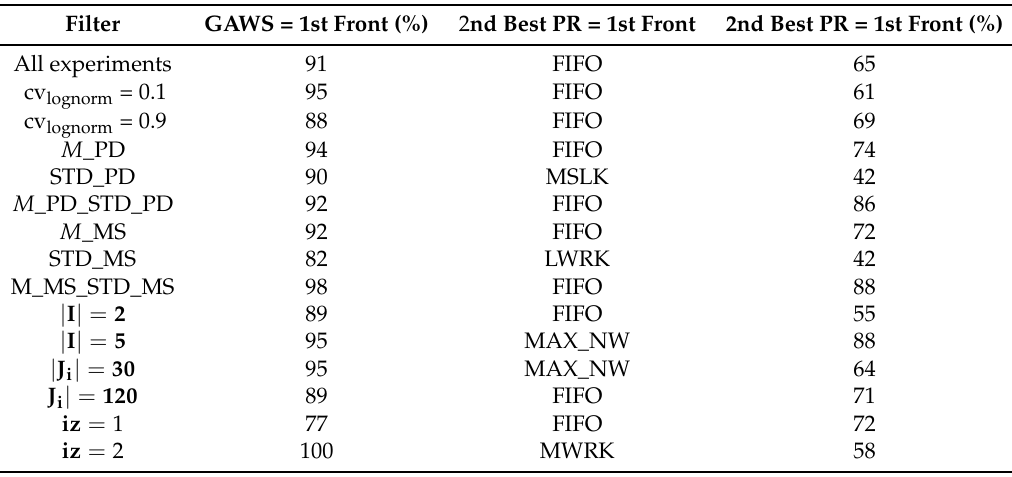
Table 5. Comparison of objective fulfillment with Pareto